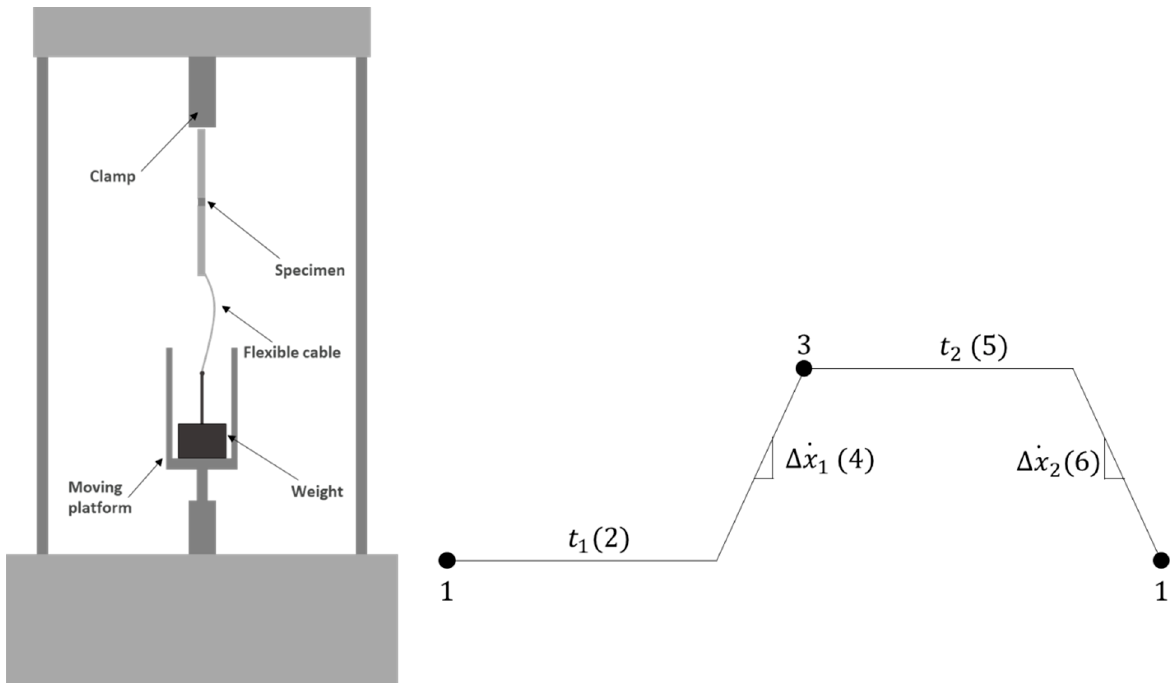
Figure 5. Servo ‐ hydraulic machine for cyclic creep testing representative scheme ( left ) and Figure 5. Servo-hydraulic machine for cyclic creep testing representative scheme ( left ) and schematic schematic stages for wave generation ( right ). stages for wave generation ( right